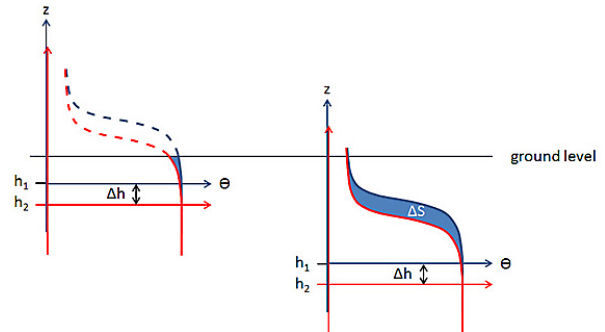
Fig. 2. Equilibrium soil moisture profiles for different levels, h, of the groundwater table. z is height and θ is volumetric water content. The broken lines above the ground surface are parts of the water retention curve, showing the water content that would have been at these levels if the soil would have continued up to the